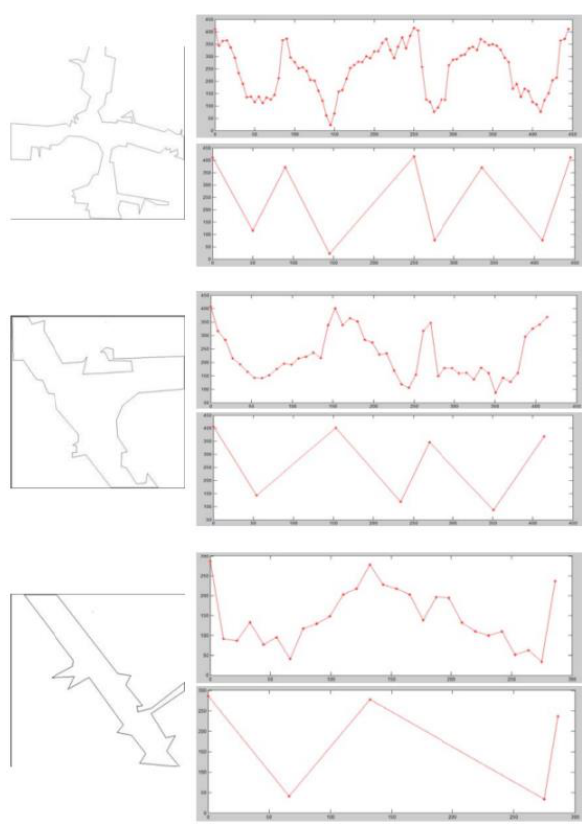
Figure 5. Examples of intersection segments and their shape